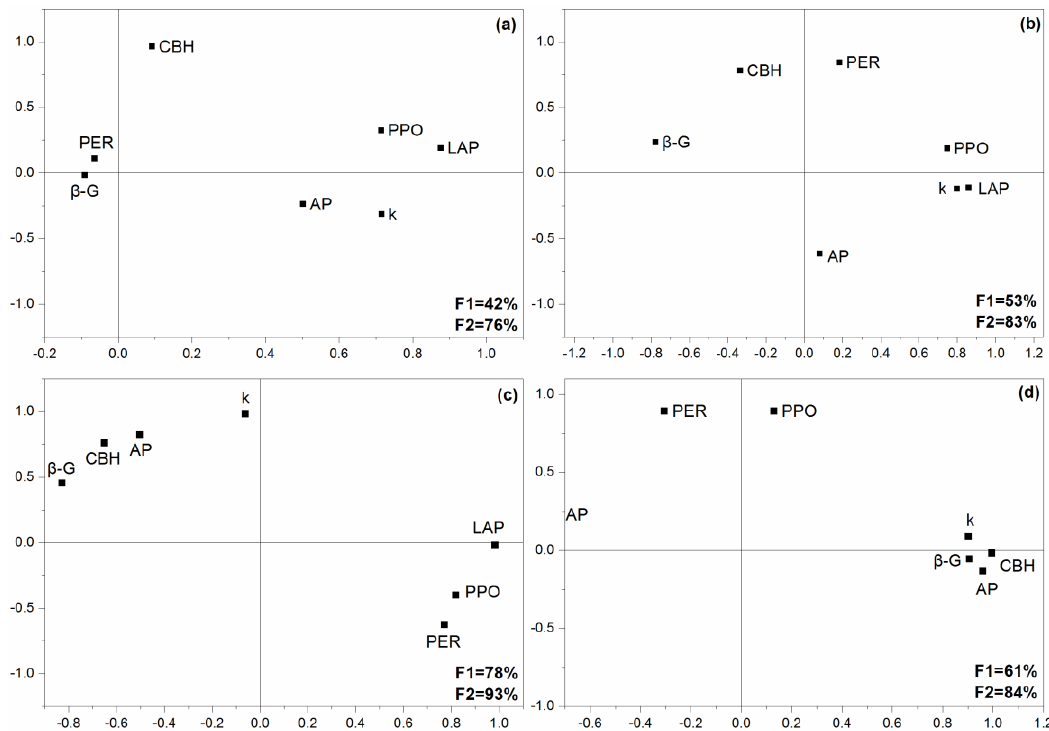
Table A2. Hydrographical and chemical characteristics of stream waters during leaf immersion. Par. = Parameters; DO = dissolved oxygen; Cond = conductivity; Sal = salinity; TSS = total suspended solids; DOC = dissolved organic carbon; TN = total nitrogen; TP = total phosphorus; Chl-a = chlorophyll-a; NTU = turbidity; OPR = oxidation reduction potential; TDS = total dissolved solids oxygen; T = temperature.